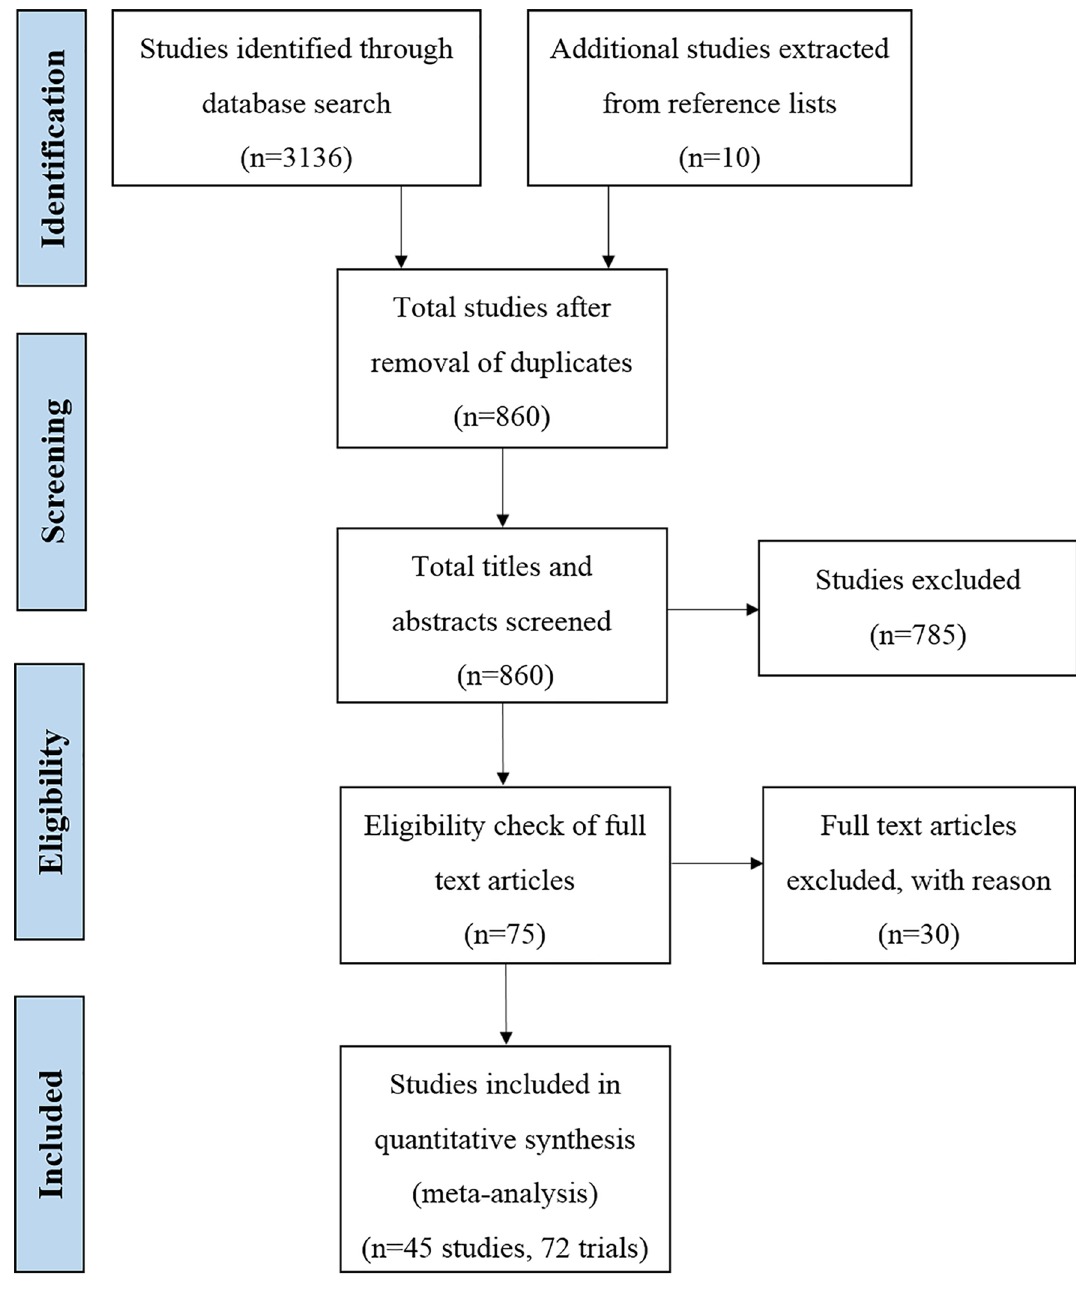
Figure 1. Flow diagram of search and selection strategy in the systematic review and meta-analysis of the reproductive success of bovine semen after